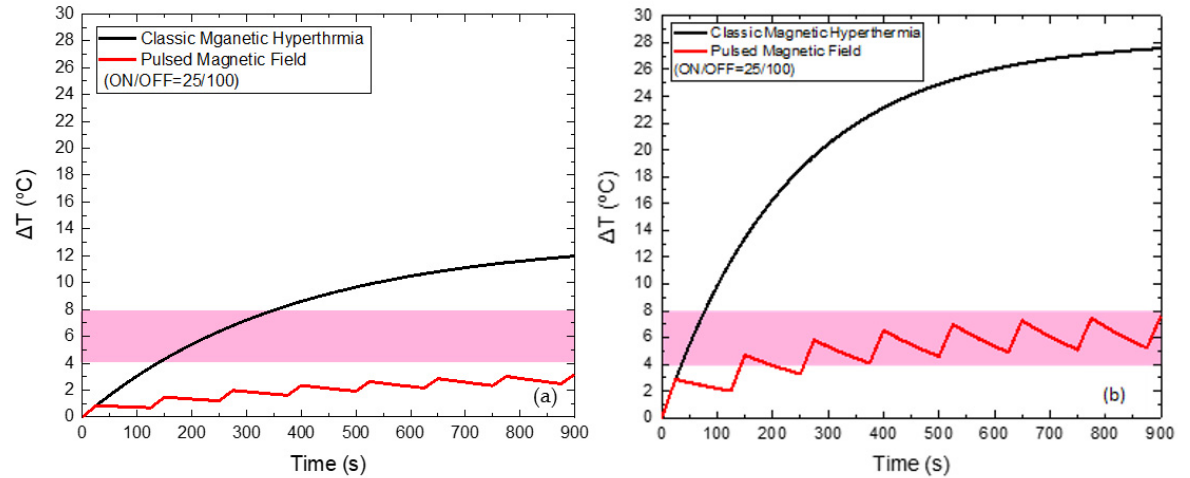
Figure 9. Temperature increase with time under 70 mT magnetic field after applying classic MPH (black) and PMF hyperthermia using ON/OFF = 25/100 s (red) for the HTP ( a ) and CTP ( b ) samples. For the AMF amplitude of 70 mT the ON/OFF sequence of 25/100 s is chosen as the optimum combination for a Duty of 25%. Since 70 mT is considered as a high field for MPH clinical application, the basic criterion is to keep the HTP sample duration as low as possible. In this way, although we exceed the limit of H × f, we succeed in minimizing the side effect in HTP—even for such a high AMF amplitude—and simultaneously maximize the damage in the CTP sample.